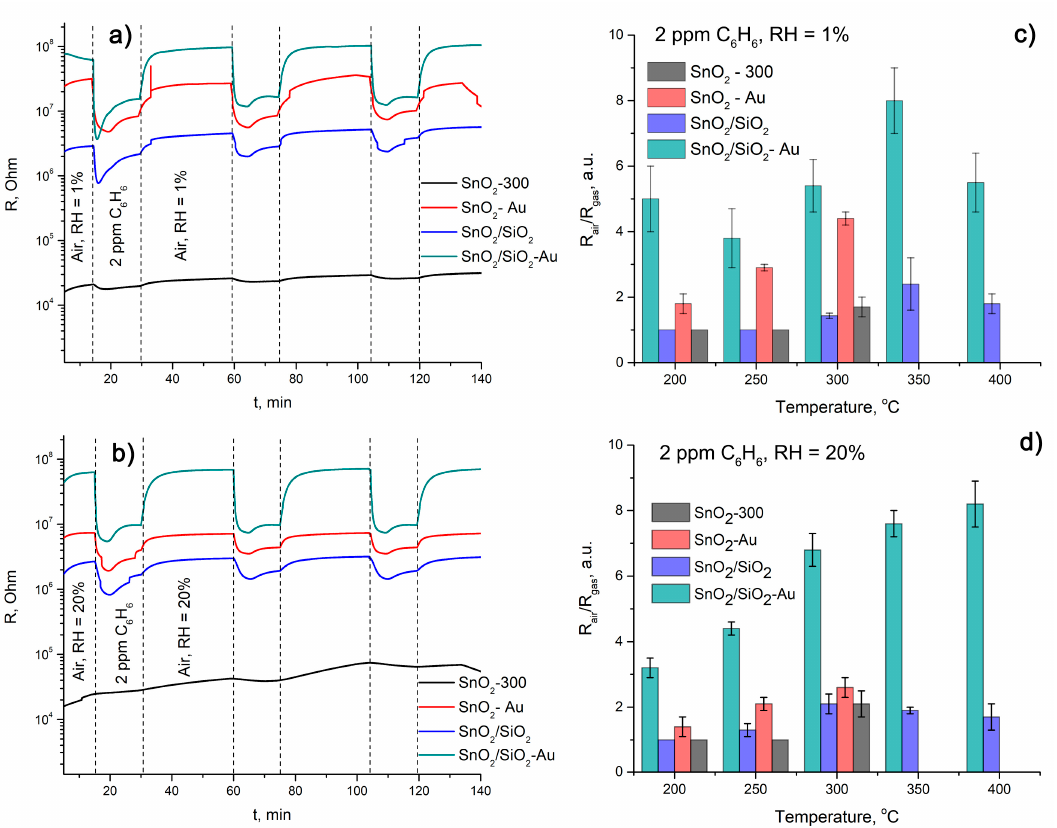
Figure 8. Change in the samples’ resistance at 300 ◦ C in the presence of 2 ppm C 6 H 6 in dry air ( a ) and at RH = 20% ( b ). Temperature dependence of the sensor response in dry air ( c ) and at RH = 20% ( d